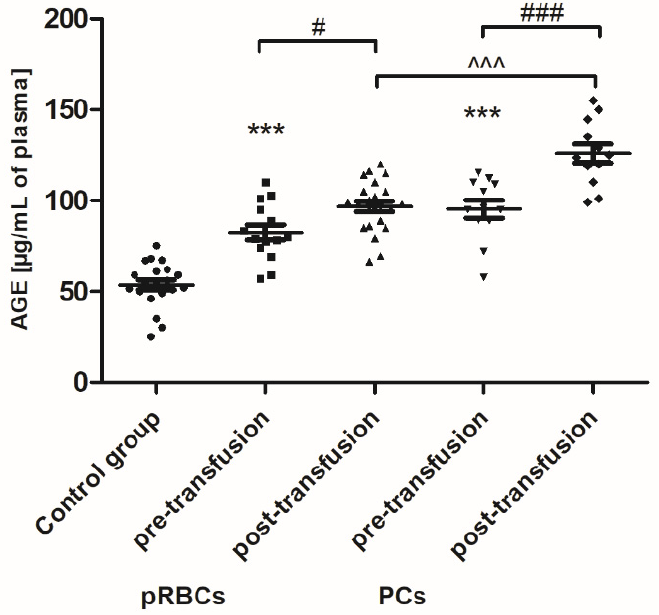
Figure 5. The concentration of advanced glycation end products (AGE) in the plasma of healthy volunteers (control group) and AML patients before and after transfusion of the blood component. Scatter plots show all of the data values obtained. Data are presented as mean ± SE. *** p < 0.001 compared to the control group; # p < 0.05, ### p < 0.001 compared post- versus pre-transfusion; ^^^ p < 0.001 compared post-transfusion pRBCs versus PCs; statistically significant according to the Tukey test. pRBCs—packed red blood cells; PCs—platelet concentrates.